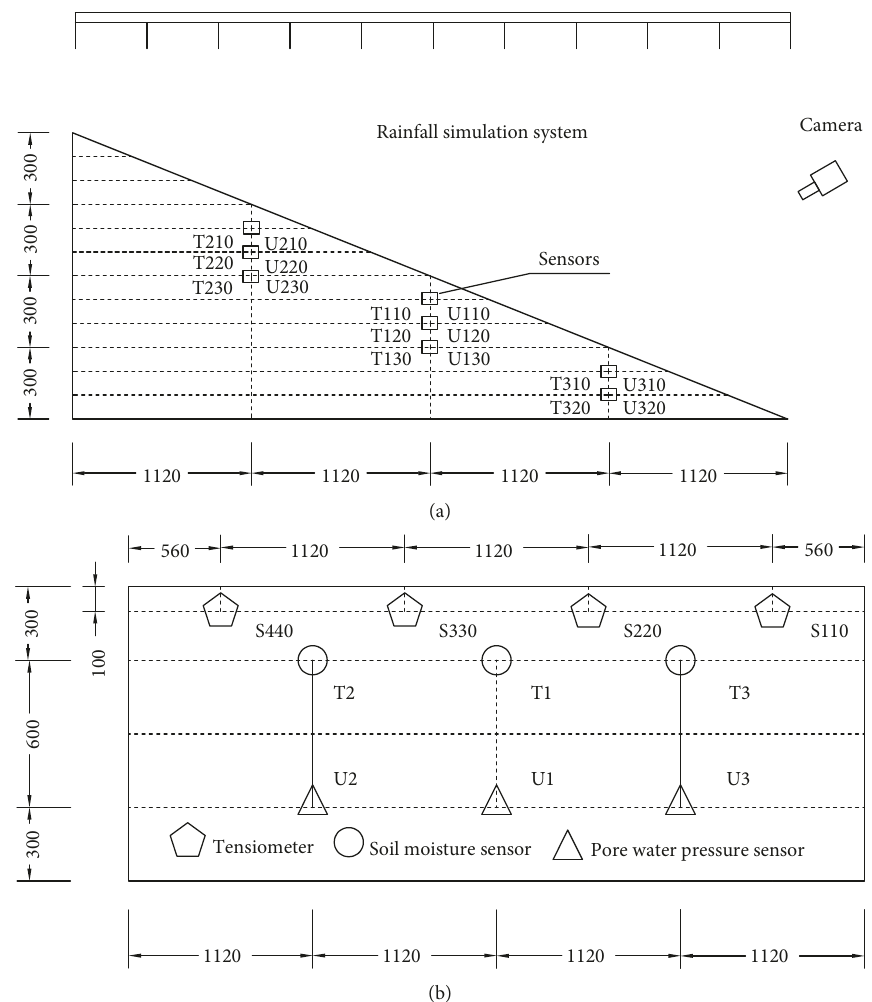
Figure 5: Detection equipment installation location map (distance measured in mm): (a) sensor burial location map; (b) sensor location plan. Table 1: Properties of tailing soil at 5cm depth.